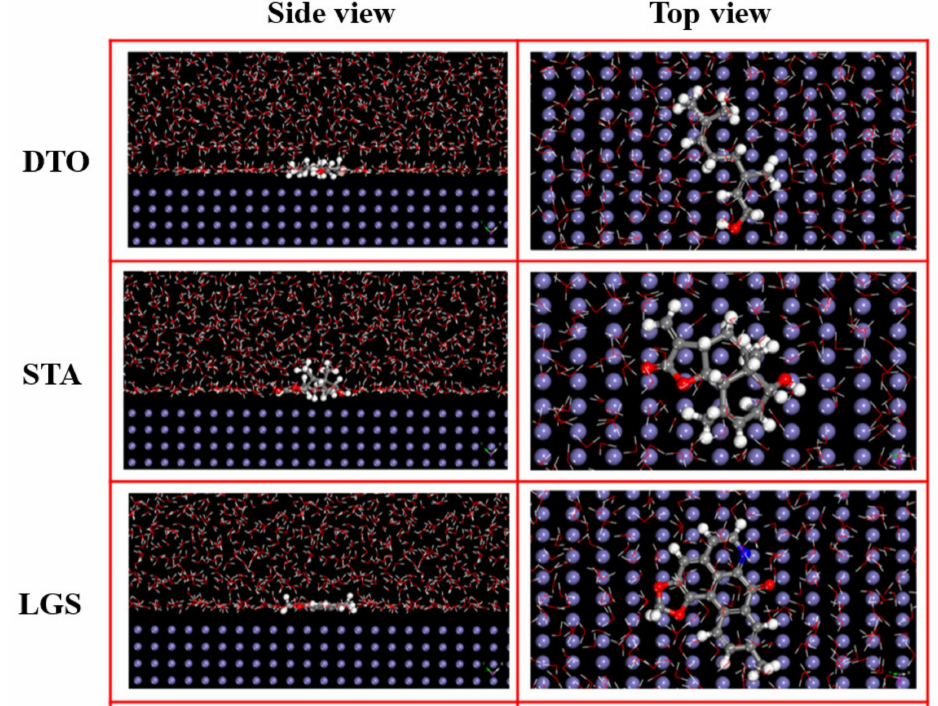
Figure 6. The stable adsorption configurations of DTO, STA, and LGS molecules on the Fe (110) surface. (Reprinted with permission from Ref. [130]. Copyright 2020 Elsevier